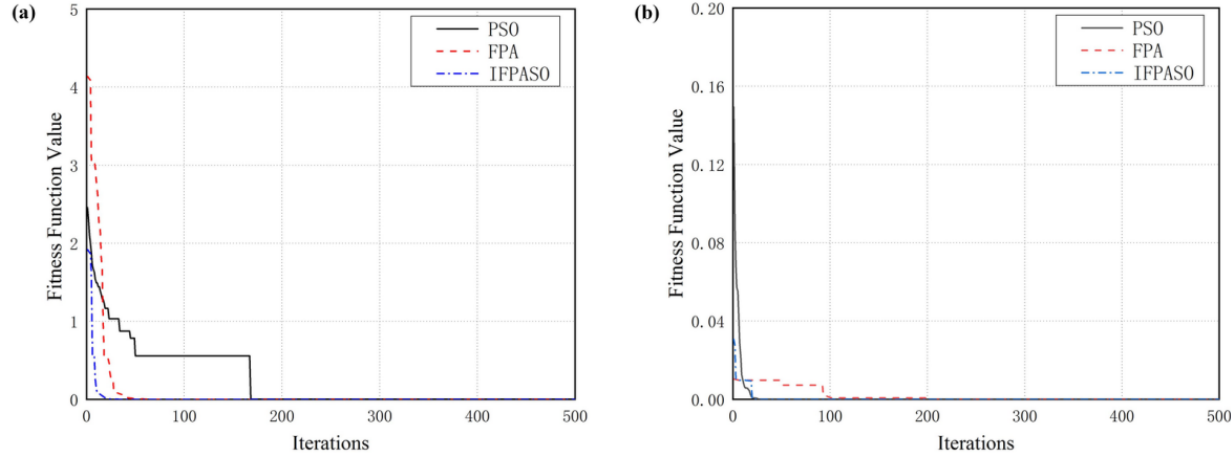
(12) Test function 2: Schaffer() function: